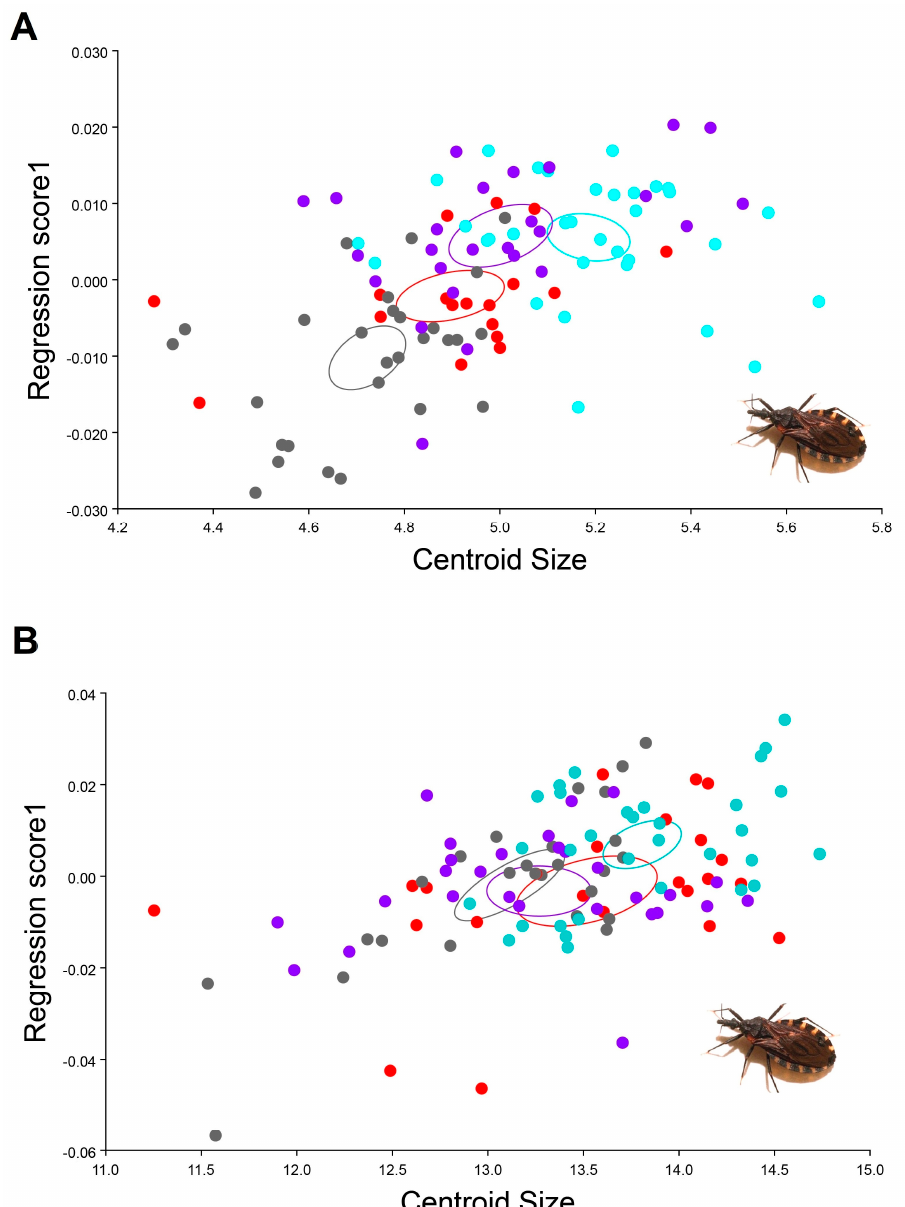
Figure 8. Multivariate regression analysis of T. infestans populations, y-axis corresponds to shape and x-axis to size (centroid size). Purple: male Andean valley, gray: male Chaco, light blue: female Andean valley and red: female Chaco. ( A ) dorsal head view, ( B ) wing view.